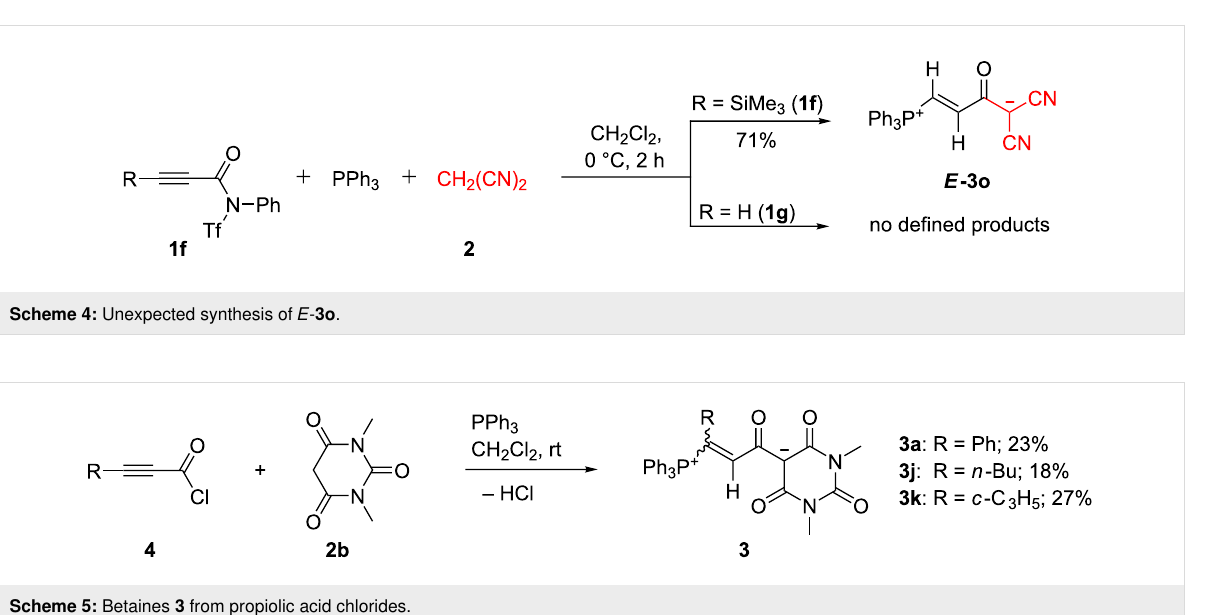
Scheme 5: Betaines 3 from propiolic acid